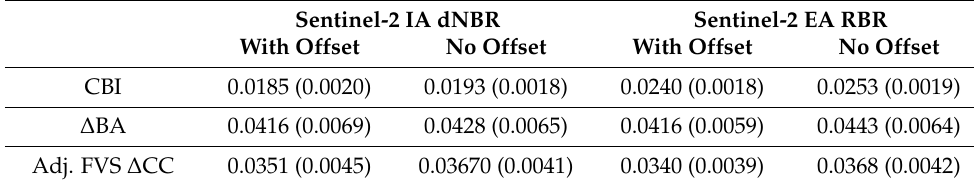
Table A8. Test MSE (and standard deviation of test MSE in parentheses) for candidate models with and without